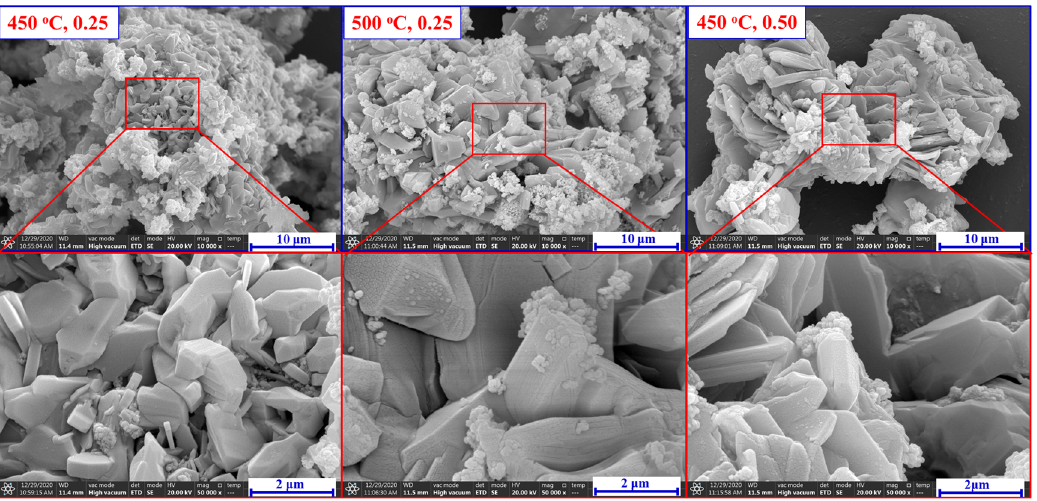
Figure 8. SEM images of samples roasted under different conditions.